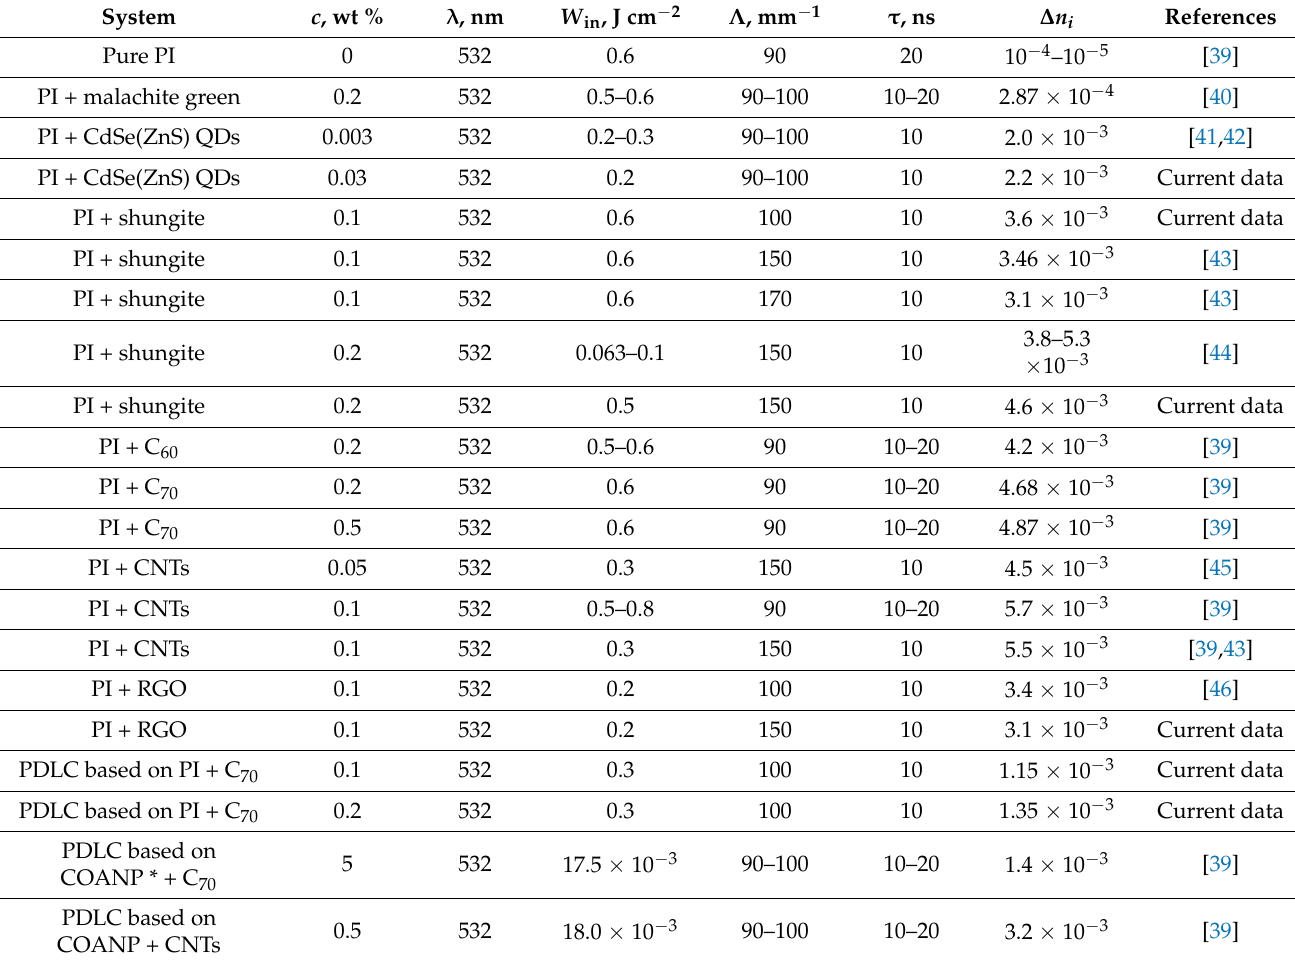
Table 1. Laser-induced change in the refractive index of the studied doped